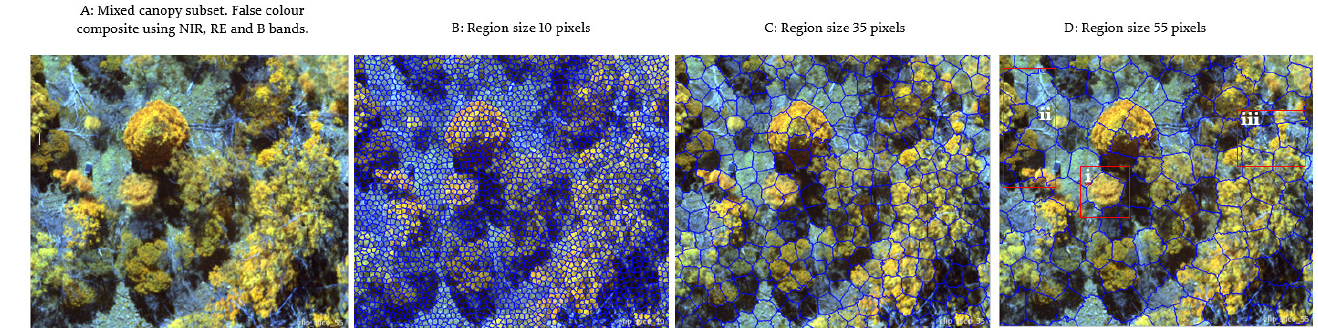
Figure 5. Superpixel segmentation results in a mixed canopy subset visualised using NIR, Red Edge and Blue bands ( A ). Region size is the average size of a superpixel. ( B ) Default value of 10 maintained image boundaries but oversegmented the image. ( C ) Average size of 35 pixels reduced oversegmentation. ( D ) Increasing Region Size beyond 35 resulted in reduced oversegmentation and superpixels representing individual tree canopies (i). However, in most areas, sizes over 35 caused undersegmentation. Different classes were grouped within a superpixel, for example, ground and canopies (ii) and overlapping canopies of different tree species Eucalyptus spp. and Acacia mearnsii canopies (iii).